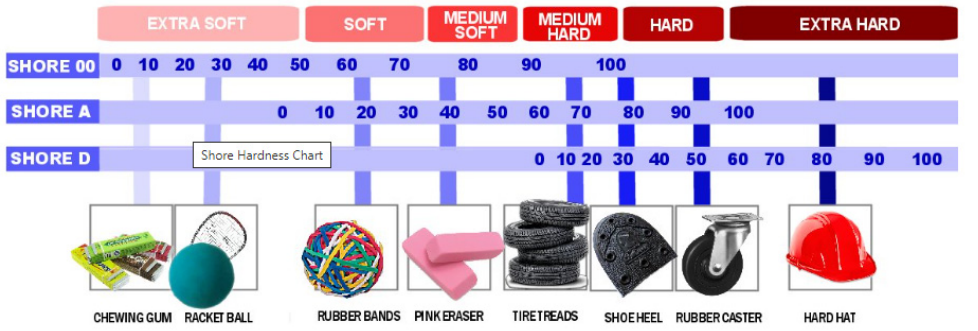
Figure 12. Shore hardness chart (sources: Smooth-on., 2019).